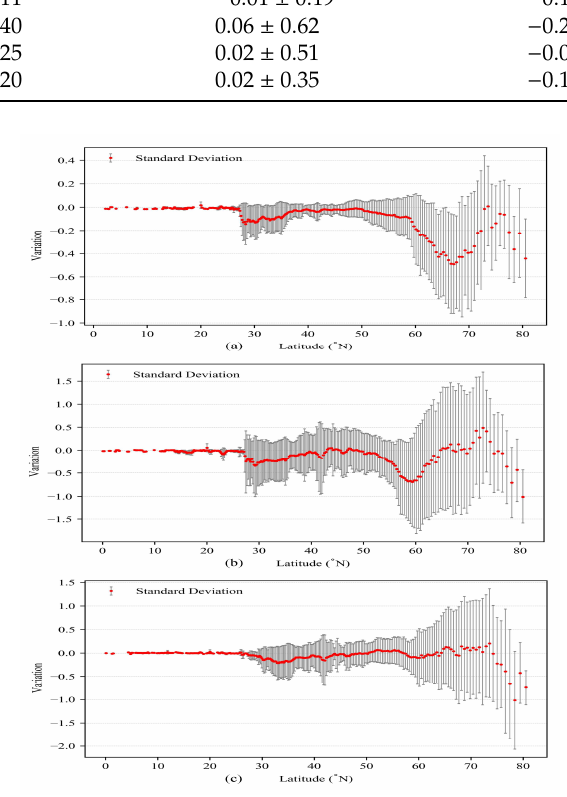
Figure 9. The zonal distributions of the seasonal average SD variation rate in ( a ) autumn, ( b ) winter, ( c ) and spring from 1992 to 2016. The error bars in ( a – c ) are the standard